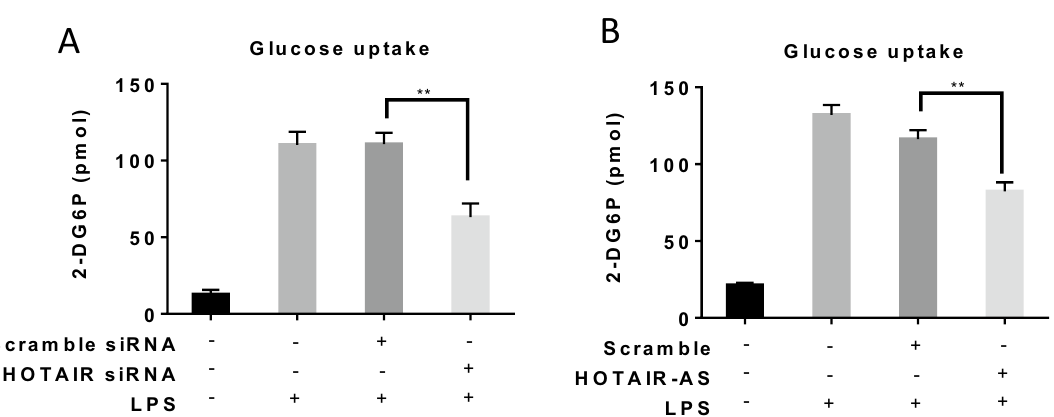
G lucose uptake